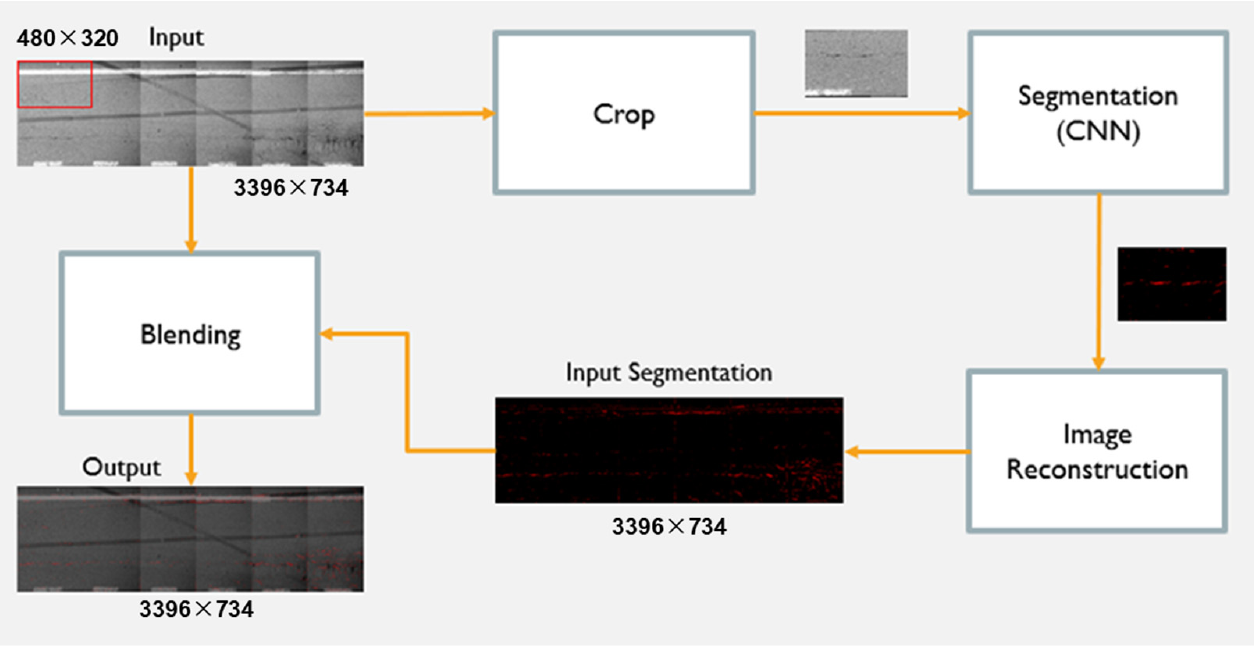
Figure 11. Road lane section processing during the segmentation step.